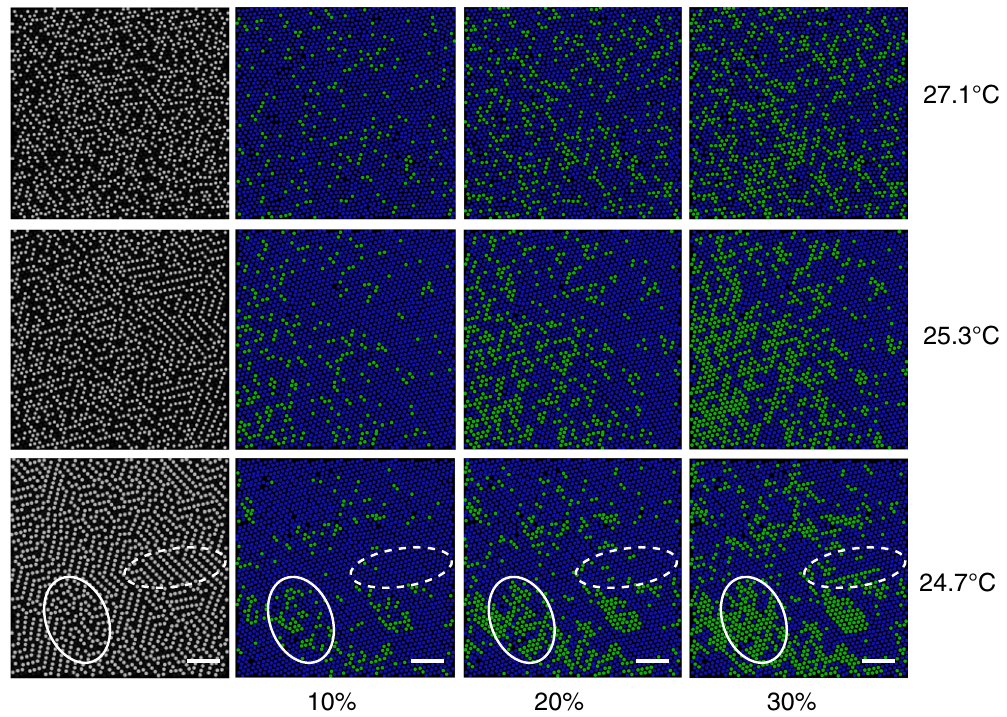
FIG. 5. Repulsive NIPA colloidal crystals at the three temperatures indicate stronger facilitated dynamics at lower T , i.e., higher ϕ . The first column shows the buckled crystals at different temperatures. The first 10%, 20%, and 30% of flipped spins are colored in green in the last three columns, respectively. They show that the newly flipped spins are mainly around the previously flipped spins, i.e., facilitation. Dashed-line and solid-line ellipses at 24 . 7 °C mark an ordered and a disordered region, which correspond to nonexcited and excited regions,